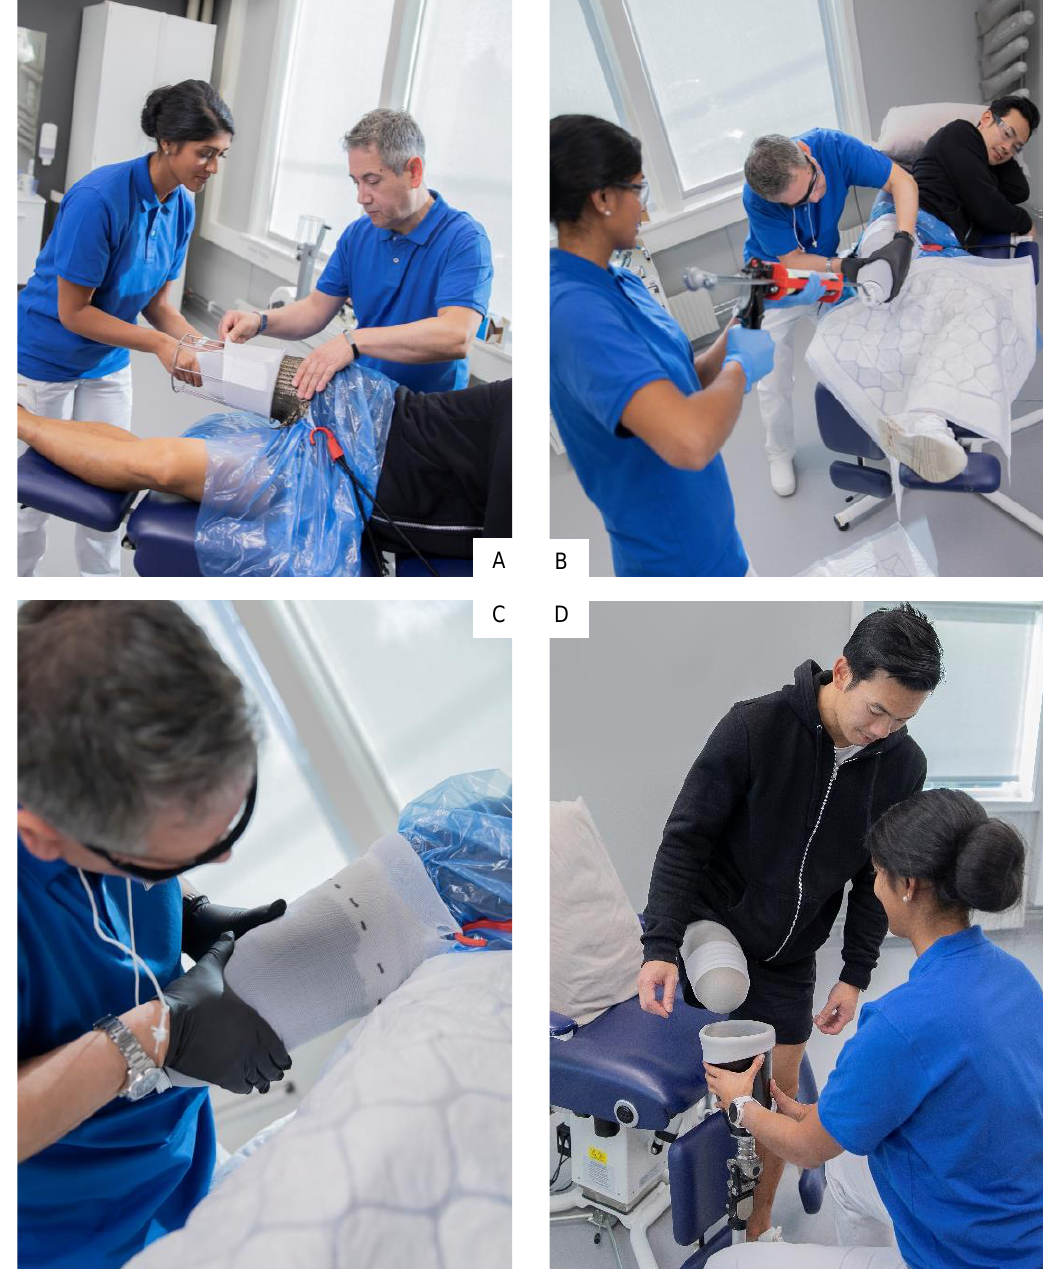
Figure 2 : DS-TF process A) application of material, B) resin injection, C) moulding of resin, D) first fit and alignment